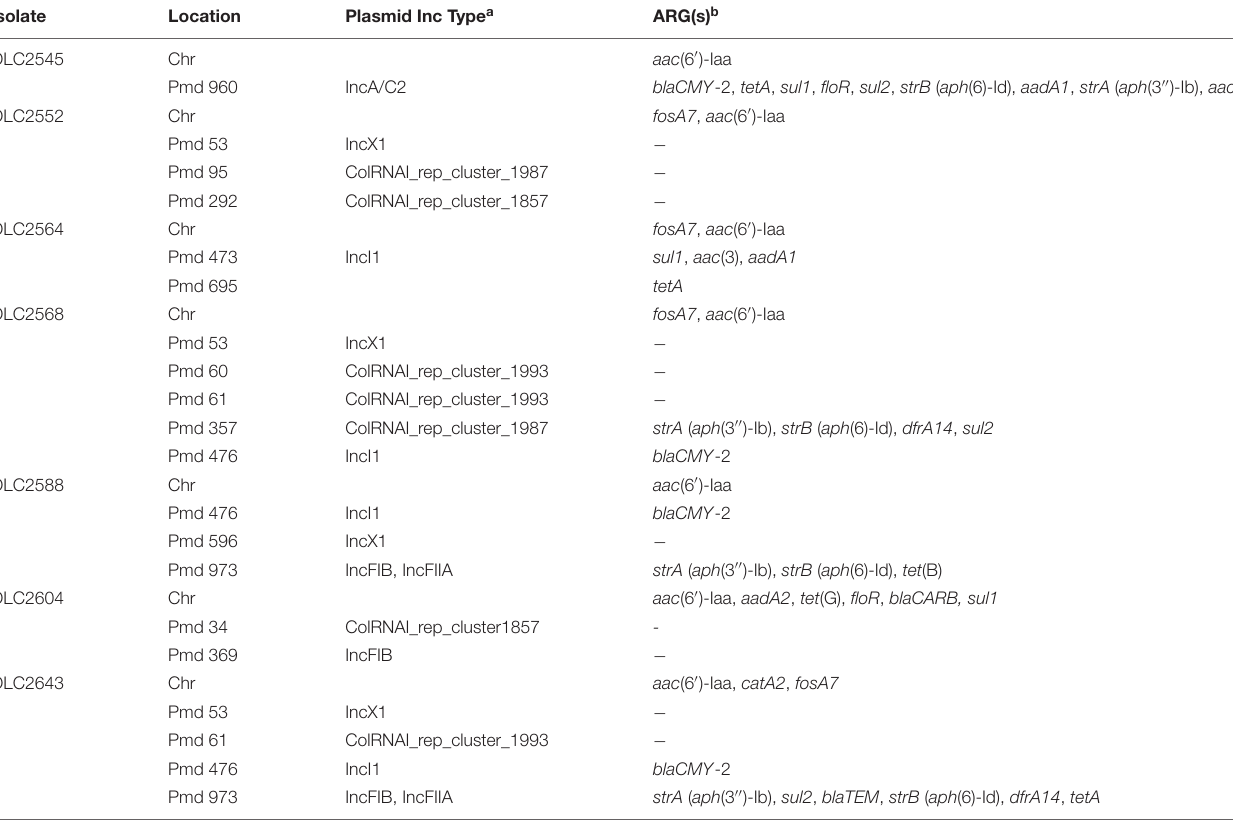
TABLE 3 | ARG profiles and locations in subset of S . enterica subspecies enterica isolates used for assembly versus raw-read analyses. Isolate